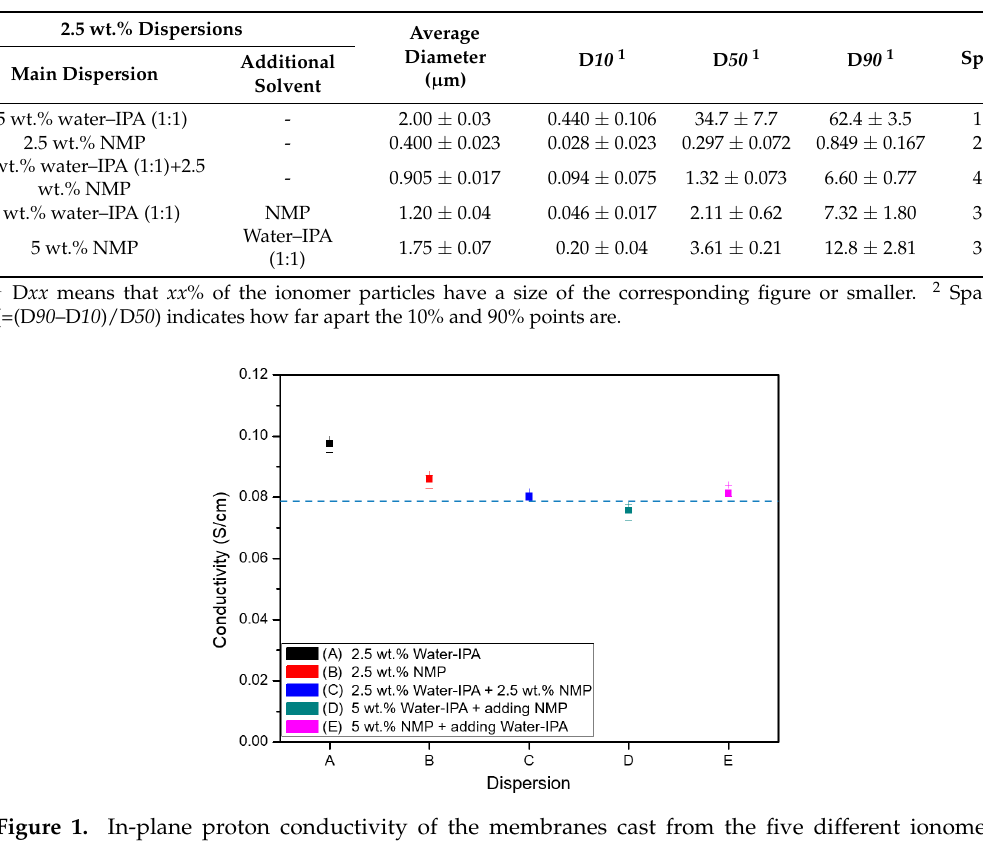
Table 1. Summary of preparation methods of five different ionomer dispersions and their dynamic light scattering (DLS).